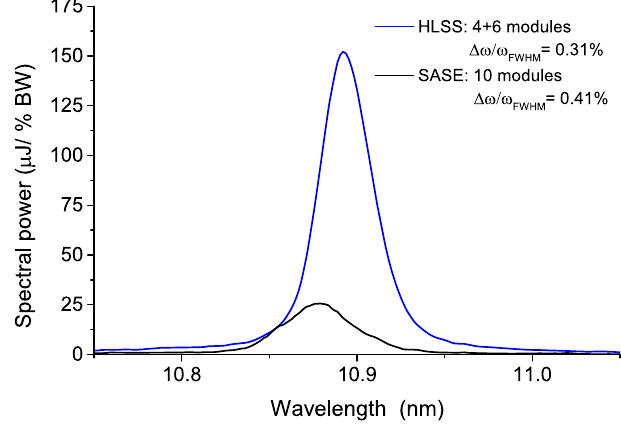
FIG. 5. Spectral density of the radiation energy for HLSS FEL configuration (blue) and for SASE FEL